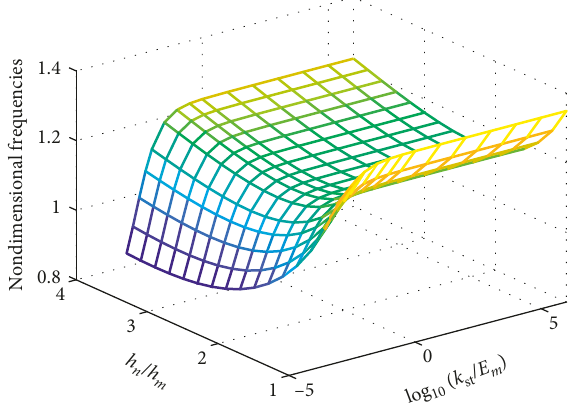
Figure 12: Nondimensional fundamental frequencies as a function of h n / h m and a / b of the SSSS plate with k Table 11: Influence of ratio k mental frequency of the plate with a / b � 1 and h n / h m � 1.